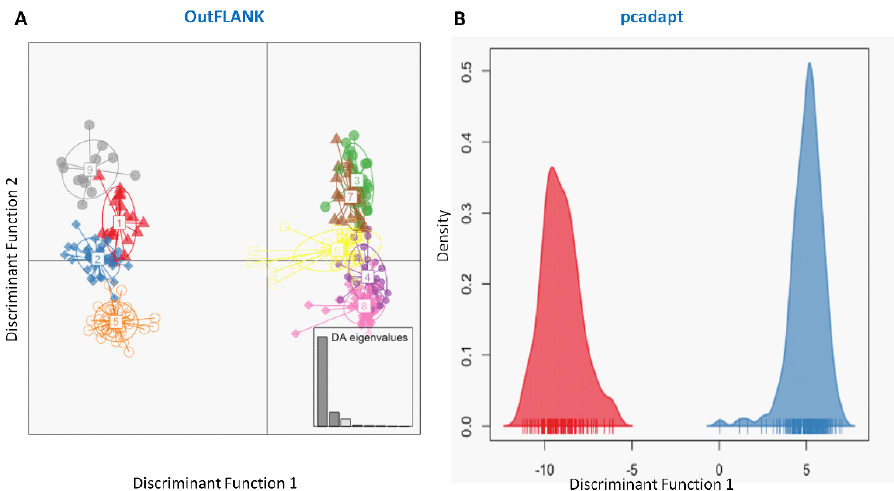
Figure 5. Plots showing the discriminant analysis of principal components (DAPCs) of genetic differentiation for the putatively adaptive panels of SNP loci in the F ST OutFLANK ( A ) and pcadapt approaches ( B ). The DAPCs of the putatively adaptive panels of SNP loci in the F ST OutFLANK ( A ) and pcadapt ( B ) approaches consistently determined two major clusters. One group of clusters was mostly dominated by the marine–estuarine population, and the other group was dominated by the riverine population.